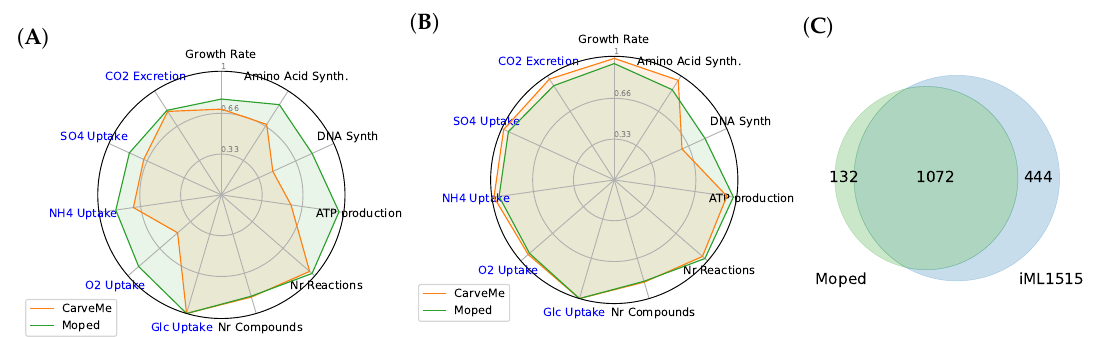
Figure 7. Functional comparison of the draft model reconstructions using moped and CarveMe with iML1515. We calculated maximal growth rates, respective ATP production rates and exchange fluxes for compounds in the medium, as well as optimal production rates for amino acids and nucleic acids for completely unmodified draft models ( A ) and models with identical biomass functions and reaction bounds ( B ). In the radar plots, the relative distance between the two values are reported. Panel ( C ) shows the overlap of GPR annotations found in the draft model constructed with moped and iML1515.